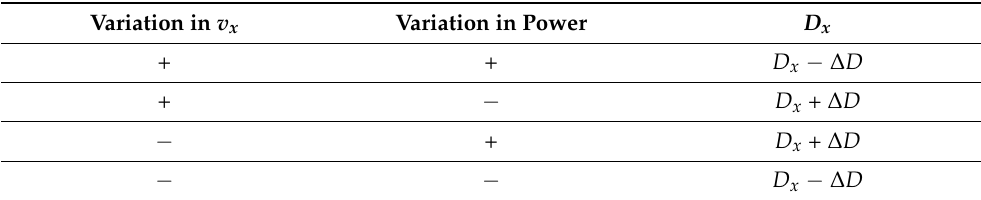
Table 1. The perturb and observe